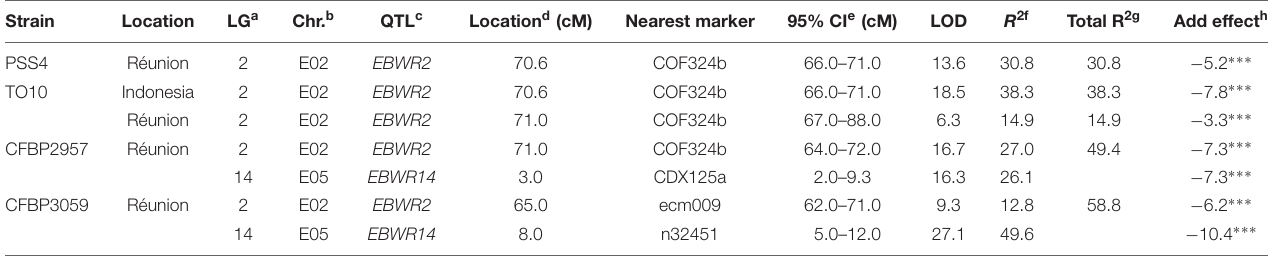
TABLE 5 | QTLs of resistance to four strains of R. Solanacearum species complex, detected by Composite Interval Mapping and Haley–Knott regression model in eggplant [MM738 × AG91-25] RIL population for the Waudpc variable. Strain